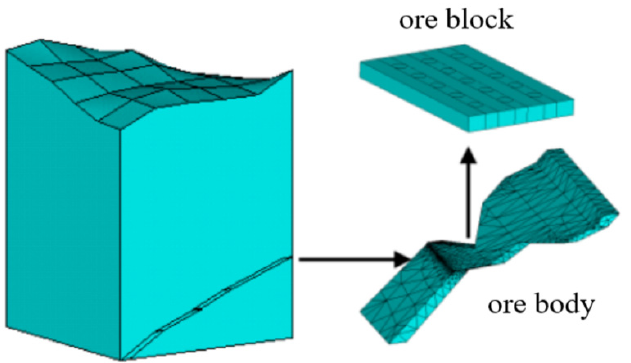
Figure 5. Finite element calculation model.